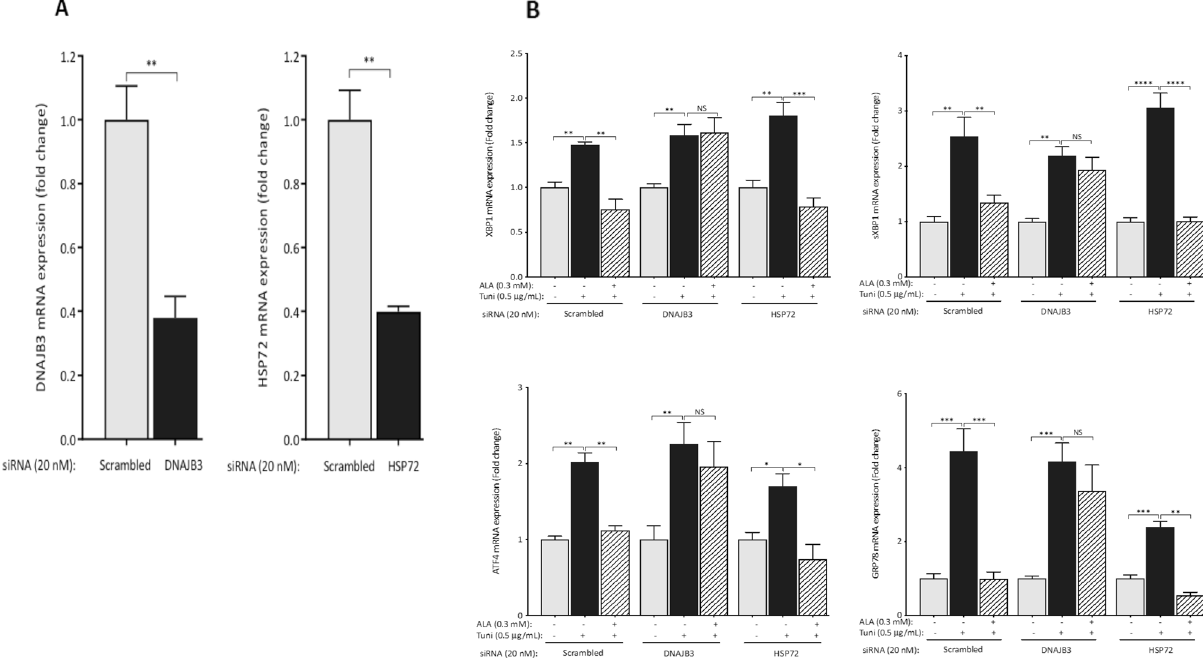
Figure 5. Silencing the expression of DNAB3 abolishes the protective effect of ALA on tunicamycin-induced ER stress in HepG2 cells. ( A ) Knocking down the expression of DNAJB3 and HSP72 mRNA with 20 nM of specific siRNA reduced significantly the endogenous expression of DNAJB3 and HSP72 mRNA. Actin gene was used as a reference control. ALA fails to protect cells from tunicamycin-induced mRNA expression of ER stress markers ( B ) and ATF6-dependent luciferase activity ( C ) in cells transfected with siRNA specific for DNAJB3. Ethanol and DMSO were used at 0.25% as vehicles for ALA and tunicamycin, respectively. After performing Shapiro–Wilk normality test, t test was used to compare the difference between ALA and vehicle ( A ) and two-ways ANOVA was used to compare the effect of treatments ( B , C ). NS not significant; *P < 0.05; **P < 0.01; ***P < 0.001; # P <